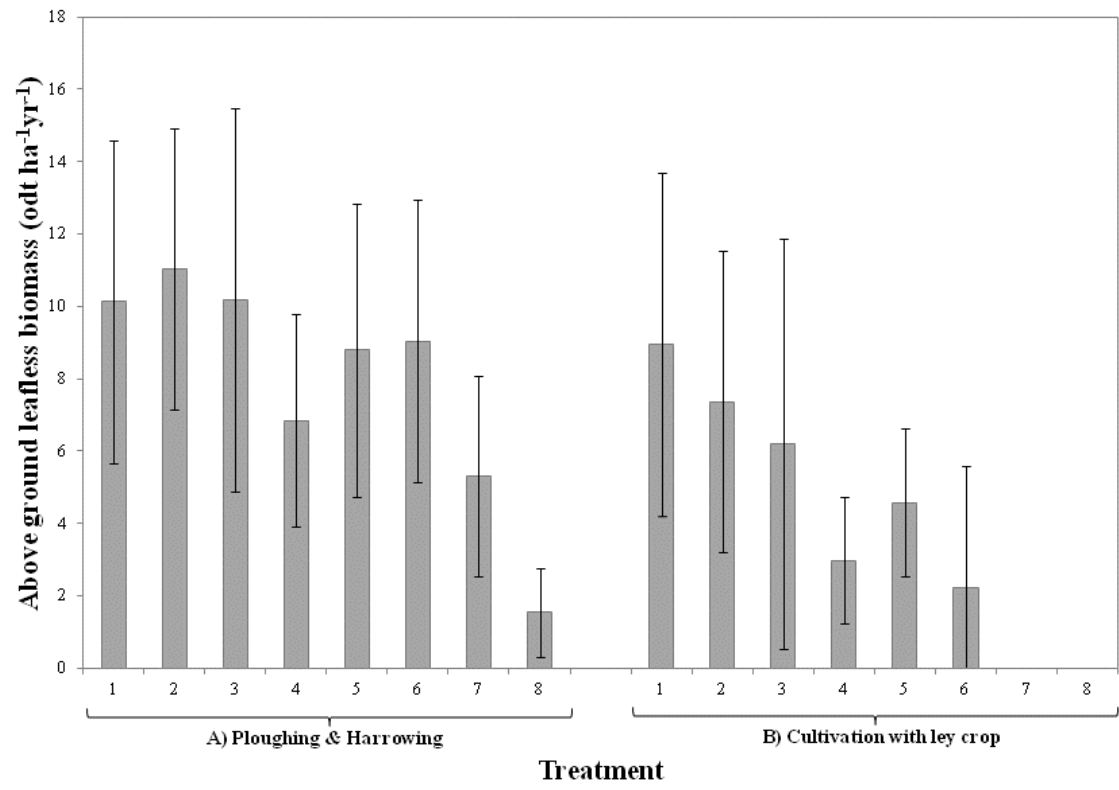
Figure 3. Biomass production per hectare and year (± SD). The x-axis shows tillage system and weed treatments as explained in Table 3. (Figure exclusive of tillage system “C” due to an excessive rate of first year